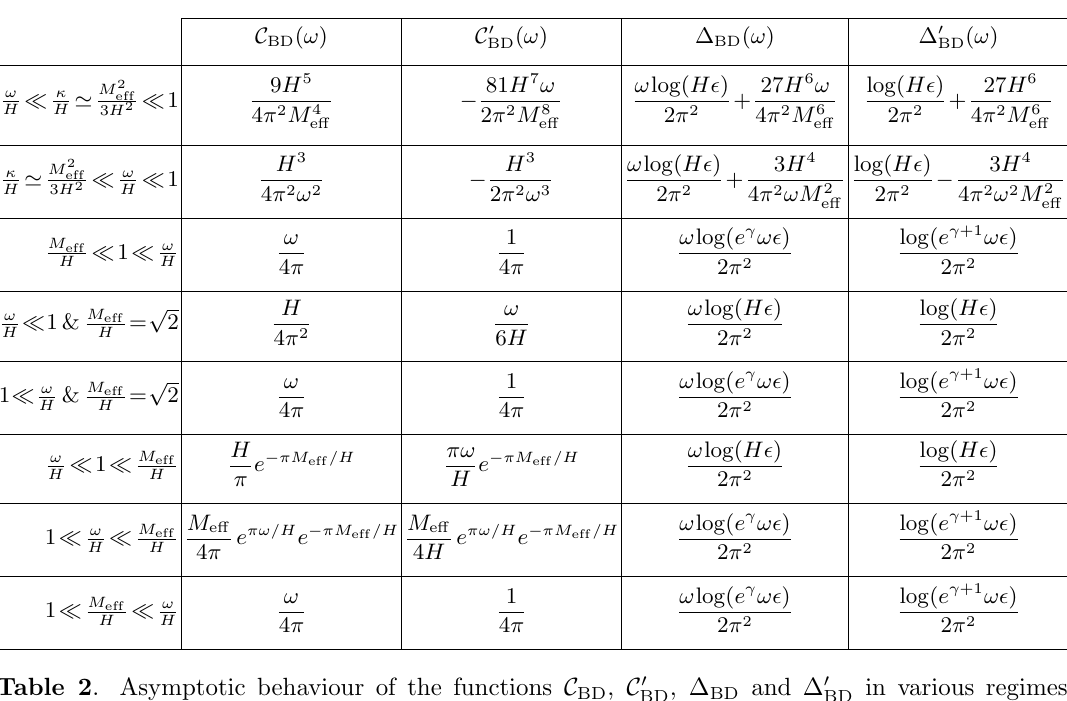
Table 2 . Asymptotic behaviour of the functions C BD , C 0 di(cid:11)ering in the relative sizes of ! , M e(cid:11) and H (see appendix B for the (cid:15) -dependence for (cid:1) BD and (cid:1) 0 ). To illustrate the behaviour of the functions for intermediate values of mass, we provide the BD behaviour for the conformal scalar case with M e(cid:11) = for the divergence in (cid:1) BD . In the limit where !=H (cid:28) 1 and M e(cid:11) =H (cid:28) 1 the functions become parametrically large (due to a singularity at ! = M e(cid:11) = 0) | the sub-leading terms in these asymptotic series are either O ( !=(cid:20) ) or O ( (cid:20)=! ) (e.g. in the very (cid:12)rst